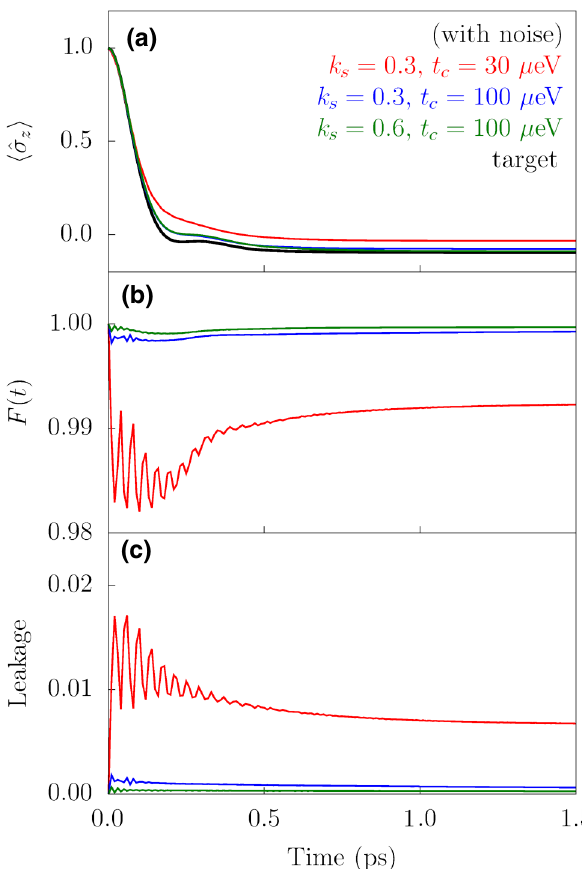
FIG. 5. The performance of the quantum simulator in the pres- ence of electrical noise that leads to fluctuations of the detuning σ = 2 μ eV. The panel distribution (cid:2) (cid:2) d with a standard deviation is identical to that in Fig. 3. In Fig. 4(d), the three specific choices of t c and k s used are signaled by the colored (red, blue, and green)